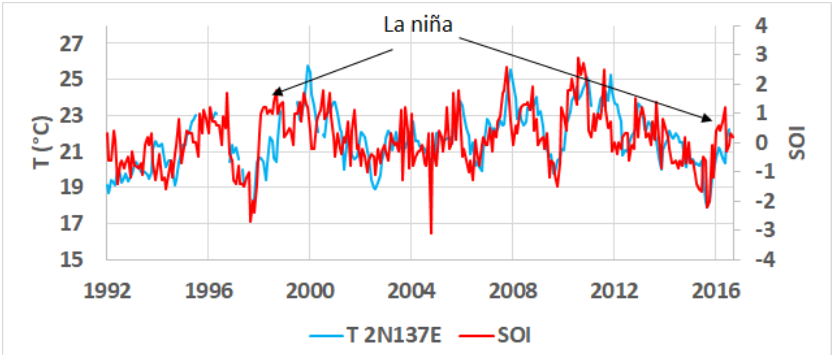
Figure 4. Comparison of the mean subsurface water temperature measured between 100 and 200 m in depth at 2° N 137° E (TAO; Tropical Atmosphere Ocean Project http://www.pmel.noaa.gov/tao/) to the Southern Oscillation Index (SOI) (https://www.ncdc.noaa.gov/teleconnections/enso/indicators/soi/). Modern means of investigation show that the correlation between the subsurface water temperature and the ENSO amplitude is even closer than Vilhelm Bjerknes had